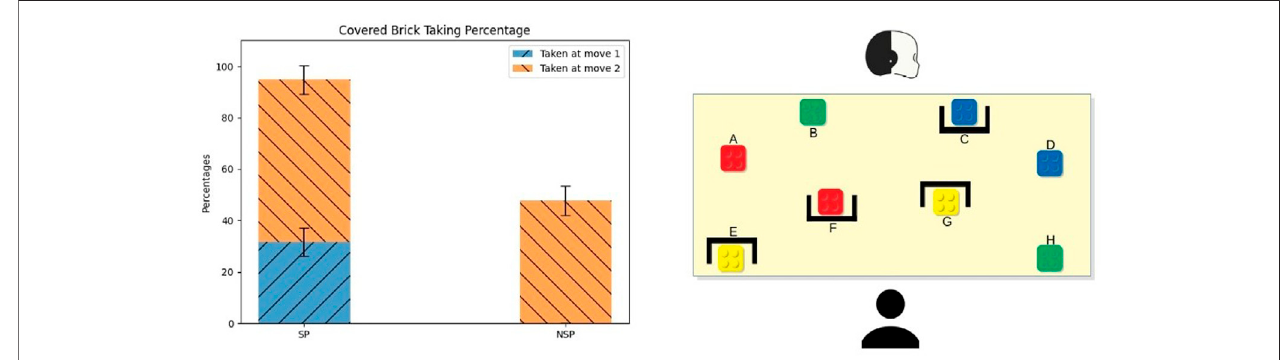
FIGURE 5 | Average and standard error of the First Brick Con fl ict ’ s covered brick taking percentage. In this case, the covered brick was the F one.